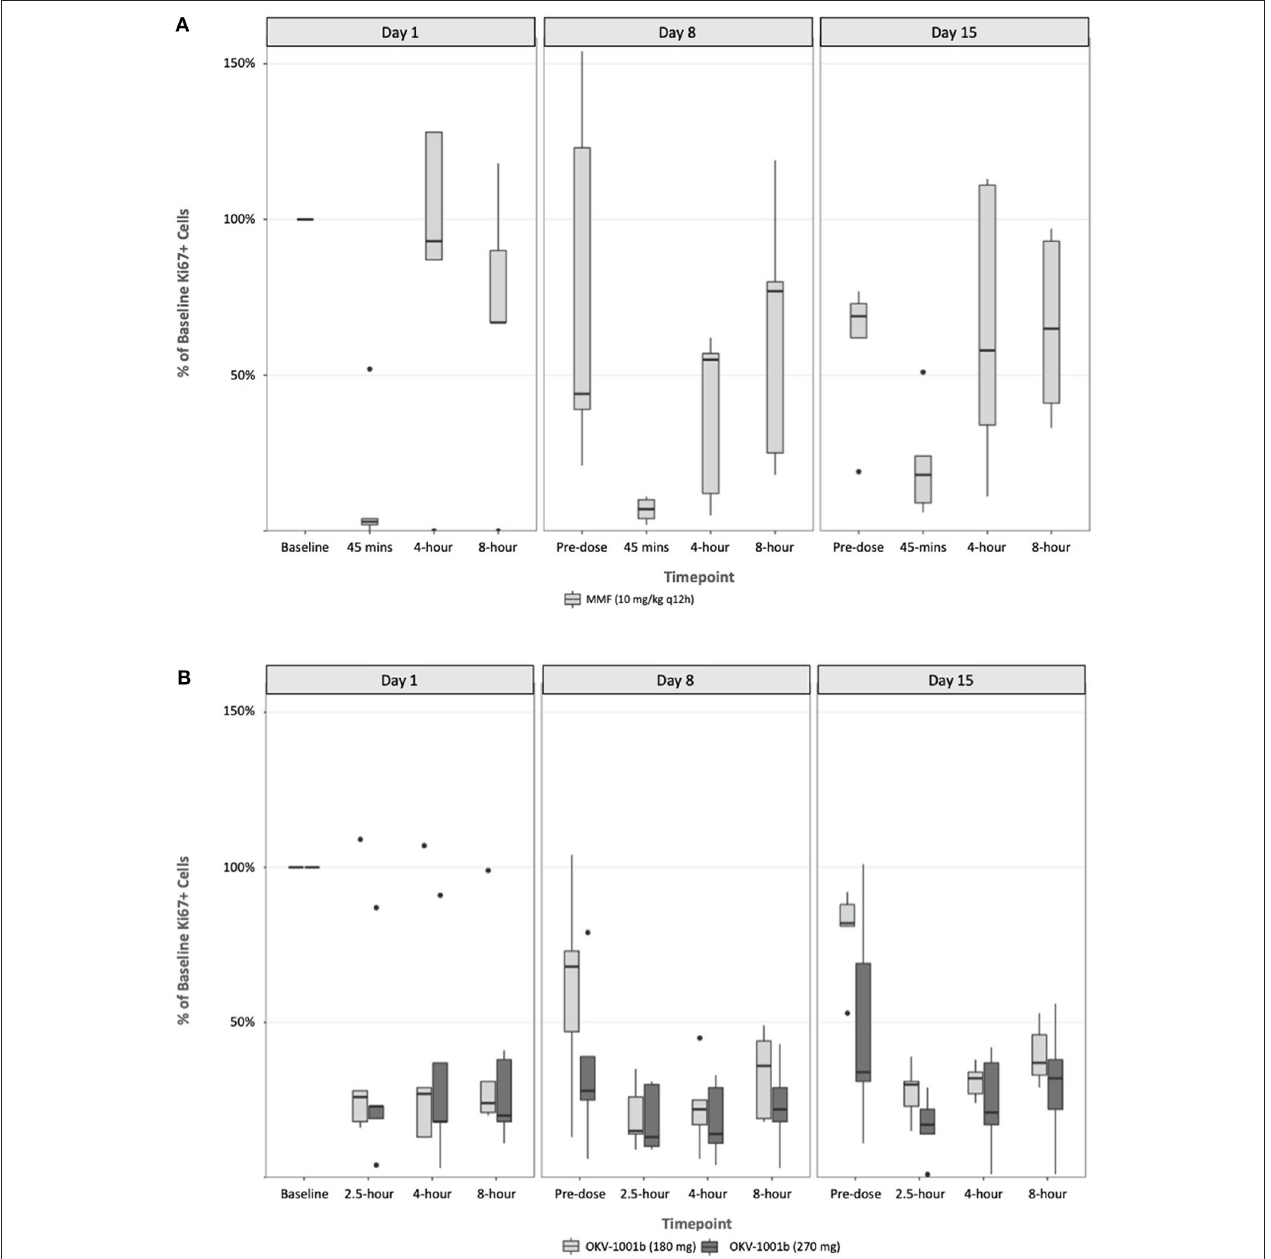
FIGURE 3 | Pharmacodynamics of single- and repeat administration of MMF (A) and OKV-1001b (280mg and 180mg; B ), as measured by ex-vivo mitogen stimulated T-lymphocyte proliferation. All pharmacodynamic results are expressed as percent inhibitions of pretreatment assay values for each dog. Boxes and horizontal bars denote interquartile range (IQR) and median percent inhibition, respectively. Whisker endpoints are equal to the maximum and minimum values below or above the median ± 1.5 times the IQR.